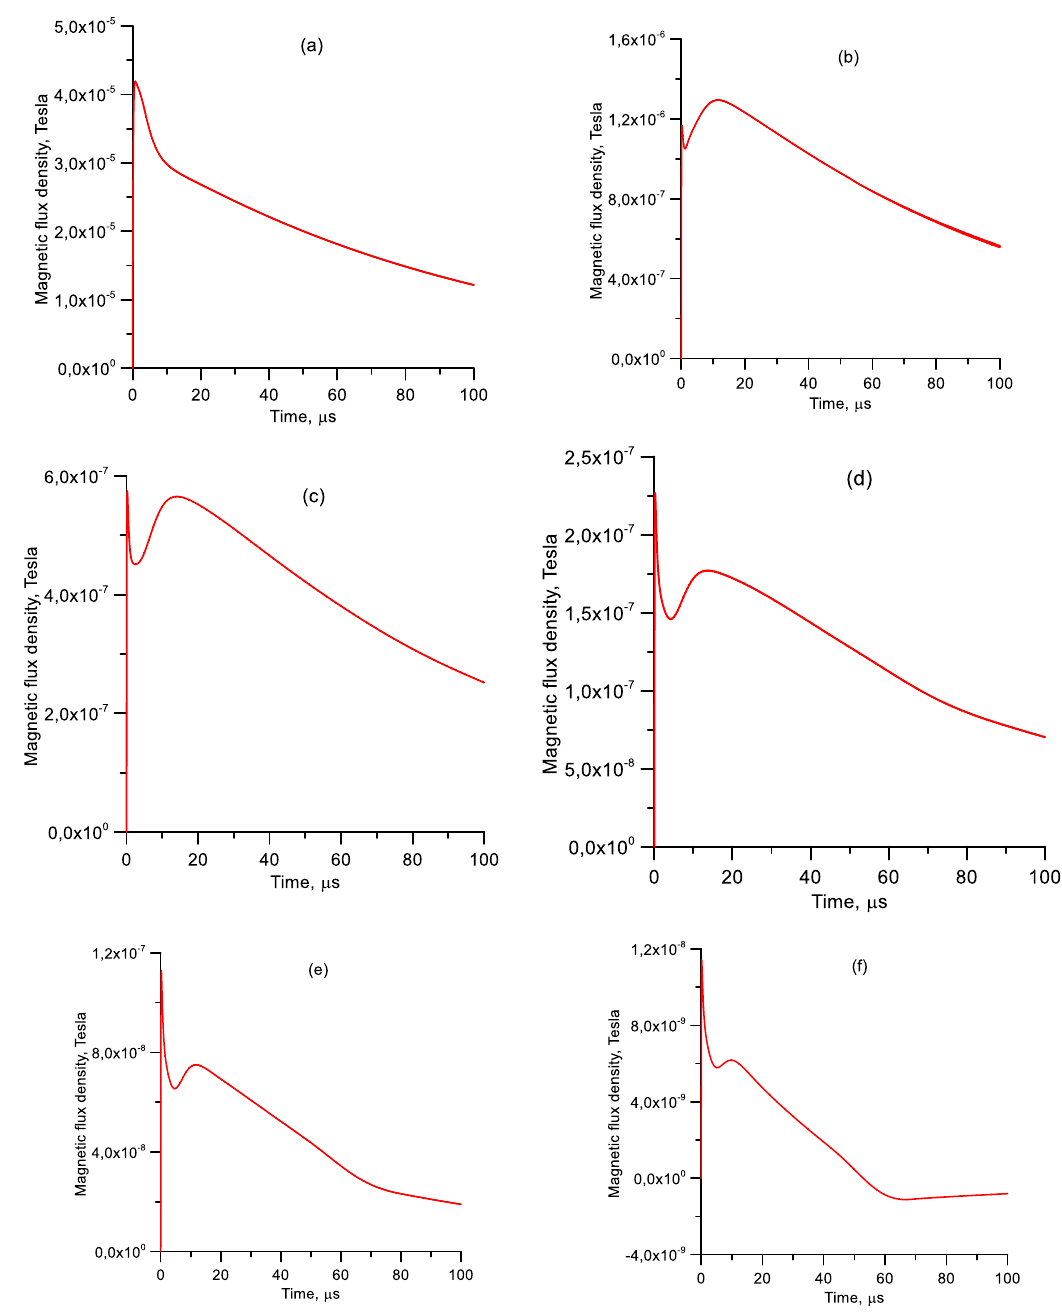
Figure 9. Magnetic field of subsequent return strokes at different distances as predicted by the MTLD model that incorporates current dispersion. ( a ) 50 m, ( b ) 1 km, ( c ) 2 km, ( d ) 5 km, ( e ) 10 km and ( f ) 100 km. The return stroke speed is assumed to be constant and equal to 1.5 × 10 8 m/s.